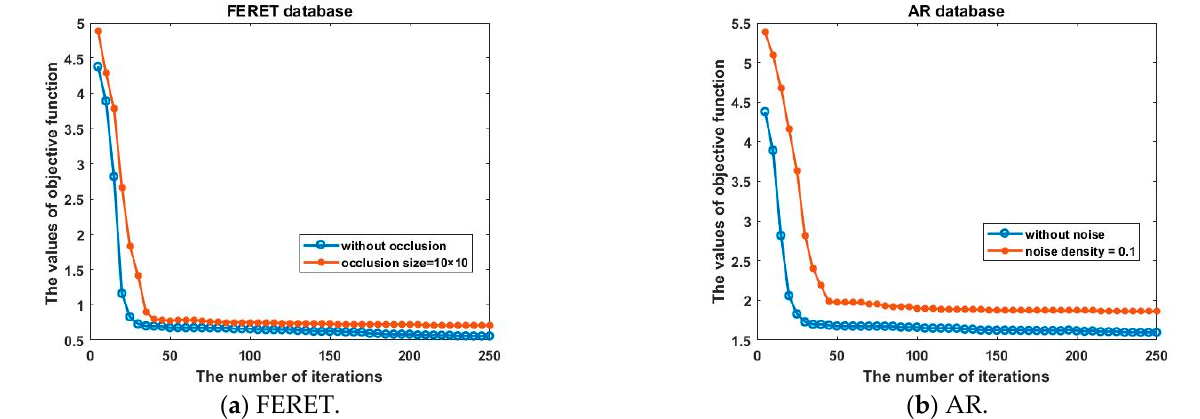
Figure 10. Convergence of the proposed algorithm. ( a ) FERET databases; ( b ) AR databases.